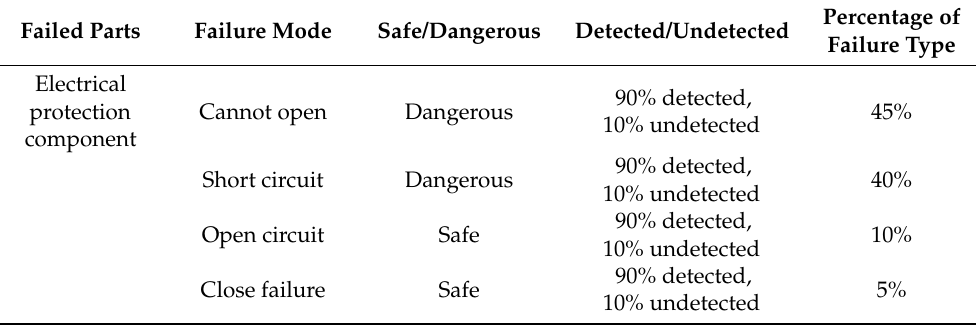
Table 7. Failure mode of electrical protection component.